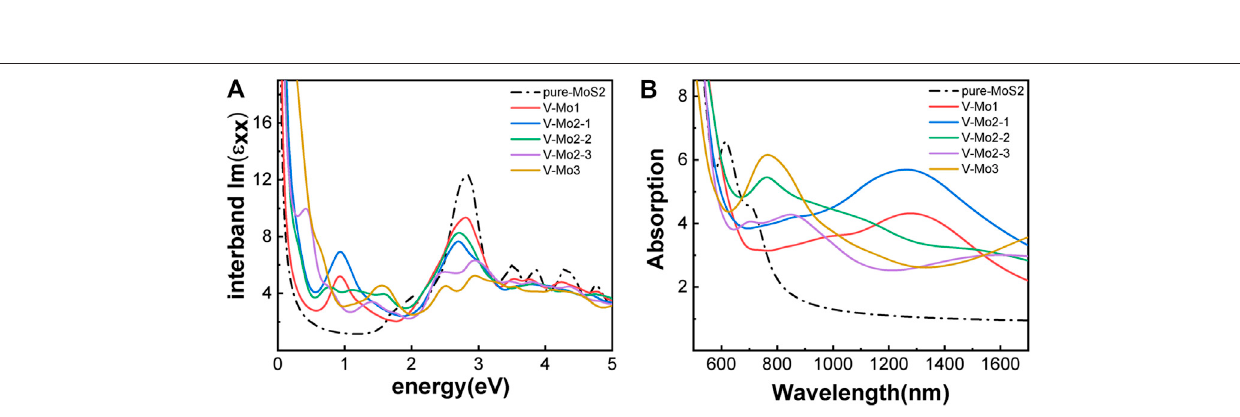
Figure 13B , the foreign atoms doped on the monolayer MoS substrate are C, Si, and Se and Ag, Au, Cr, Pd, Ru, and Sb,